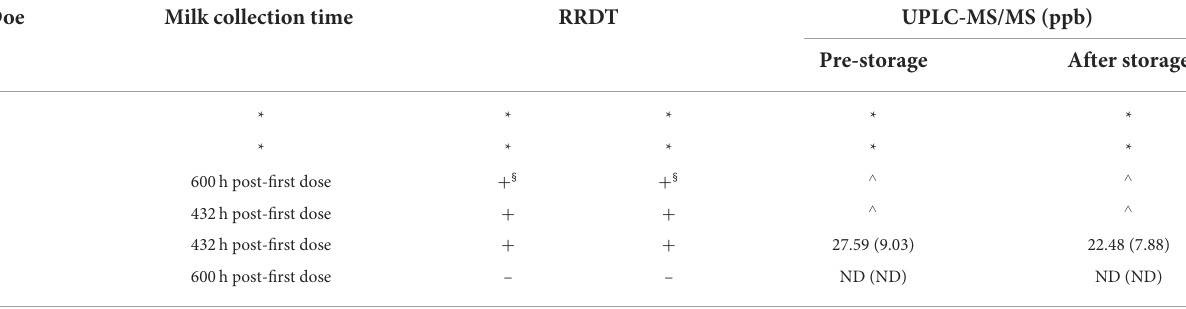
TABLE 6 Rapid residue detection test (RRDT) results and corresponding milk quantification via ultra-performance liquid chromatography with tandem mass spectrometry (UPLC-MS/MS) of florfenicol (florfenicol amine) in stored frozen ( − 70 ◦ C) milk samples for 60 days after milk collection at two time points (432 and 600h post-first